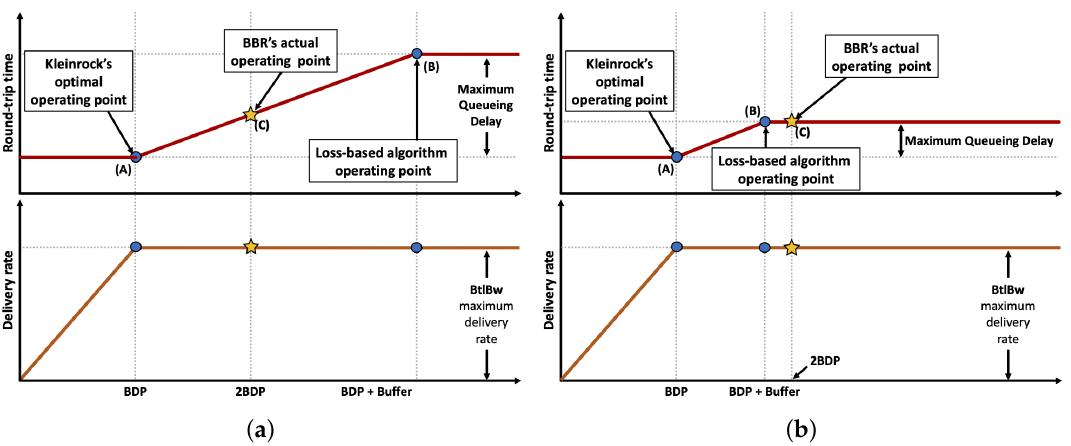
Figure 1. Delivery rate and round-trip time based on the inflight: ( a ) buffer size > 1 BDP (deep); and ( b ) buffer size < 1 BDP